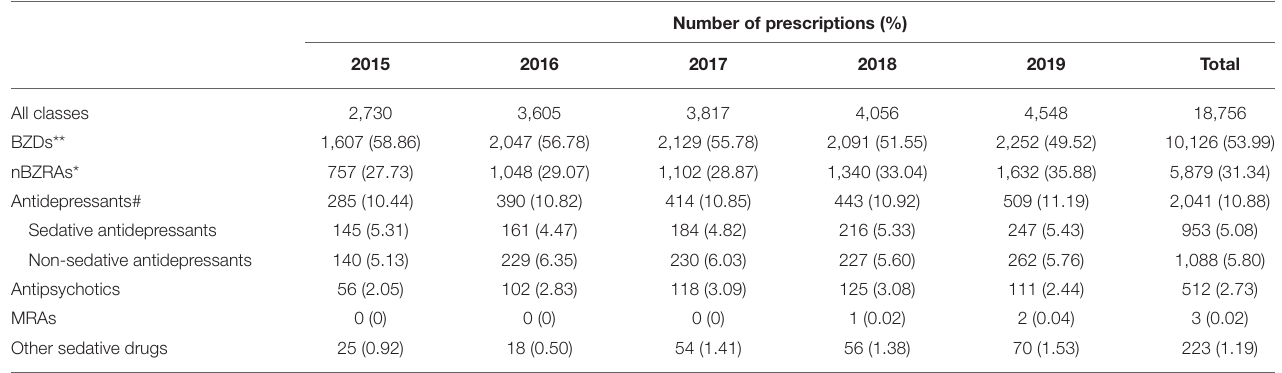
TABLE 2 | Trends of therapeutic drugs prescribed in sampled outpatients with insomnia between 2015 and 2019.